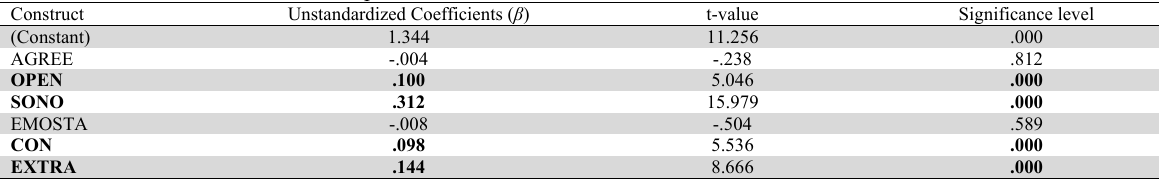
Coefficients between POSAT and independent variables